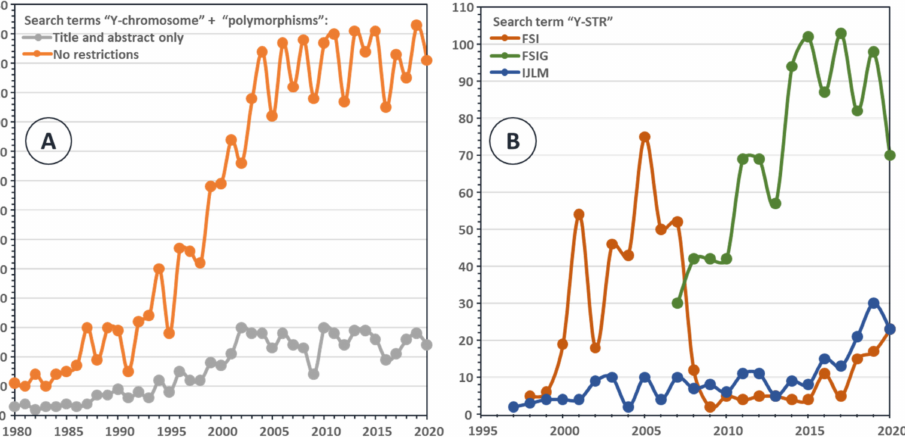
Figure 1. Bibliographic summary of published papers: ( A ) Result of a PubMed search in the years 1980–2020 with the terms “Y-chromosome” + “polymorphisms” either restricted to the title and abstract of the paper (grey) or without any restriction (orange). ( B ) Result of a PubMed search in the years 1995–2020 with the term “Y-STR” (without further restrictions) in the content of three forensically relevant journals, Forensic Science International (orange), Forensic Science International: Genetics (green; published since 2007), and International Journal of Legal Medicine